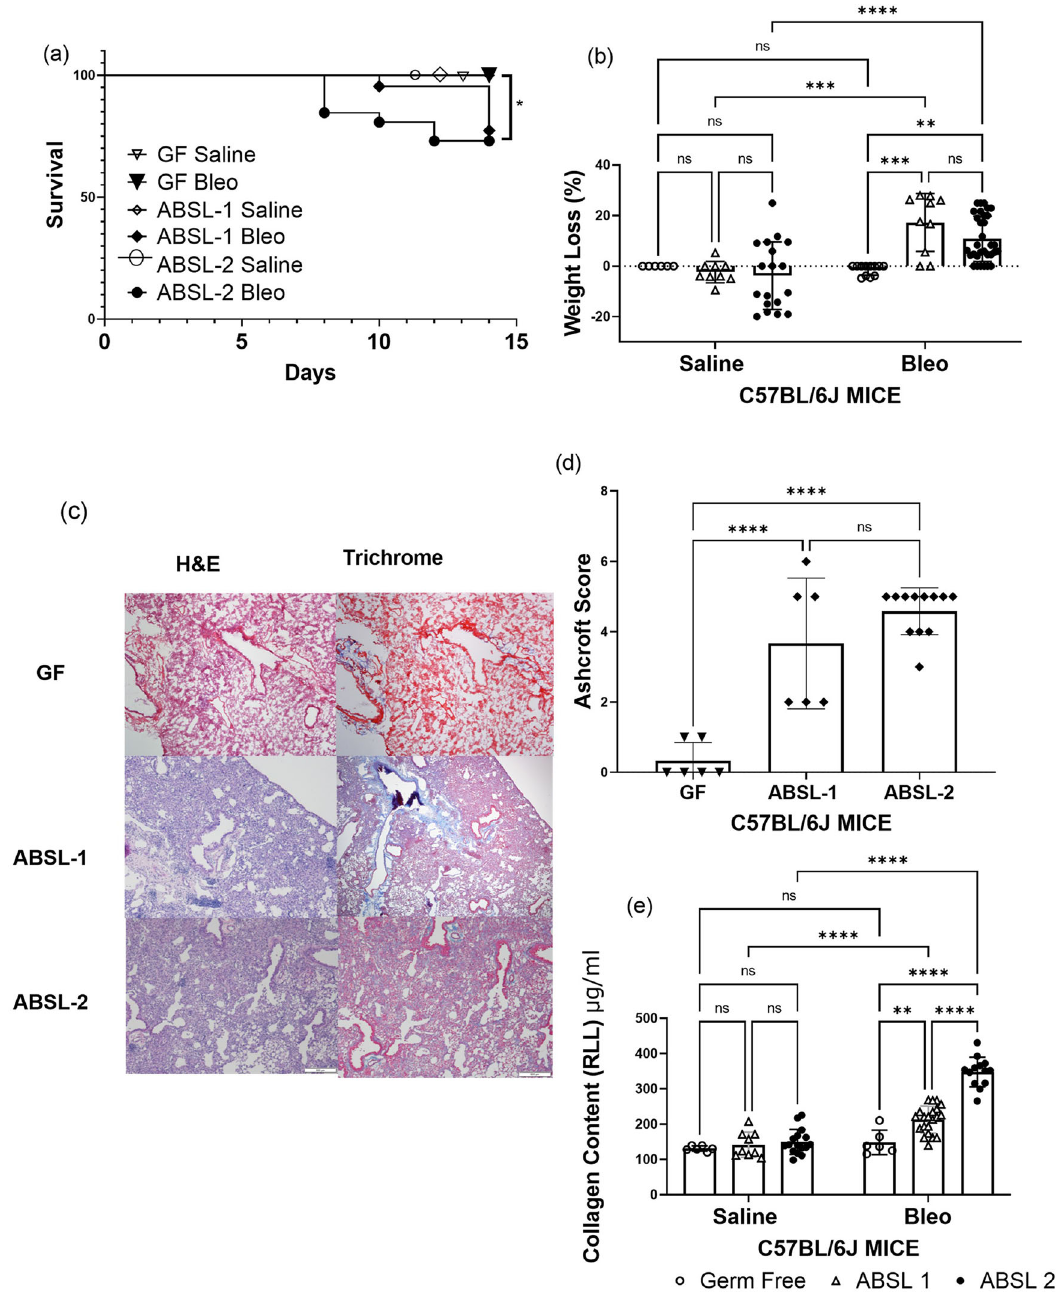
Fig. 1 Germ-free mice are protected from lung fi brosis morbidity and mortality. a Survival curve of mice housed in gnotobiotic, ABSL-1, or ABSL-2 facilities and intranasally inoculated with 75 μ l containing 0.04 Units of bleomycin. Control animals were intranasally inoculated with 75 μ l of saline. b Body weight of mice in the housing and treatment cohorts was continuously measured and recorded daily from day 1 to day 14. c Representative images for H&E- and trichrome-stained lungs of GF, ABSL-1 and ABSL-2 mice, 14 days after bleomycin injury with Scale bar, 100 μ m. d Ashcroft Scoring of trichrome-stained lungs by housing conditions following bleomycin administration to mice. e Soluble collagen content of RLL of mice exposed to bleomycin or saline treatment and housed in gnotobiotic, ABSL-1, or ABSL-2 facilities by Sircol assay; Data are reported as mean ± SD with each dot representing an individual mouse, n = 6-32 mice. The experiments were independently repeated an average of two times. Statistical signi fi cance was assessed using a two-way ANOVA with Tukey ’ s multiple comparison ’ s test. * P < 0.05 ** P < 0.01, *** P < 0.001 **** P < 0.0001; GF: Germ-free, ABSL-1: Animal Biosafety Level 1, ABSL- 2: Animal Biosafety Level 2, ns = no signi fi cance; RLL: right lower